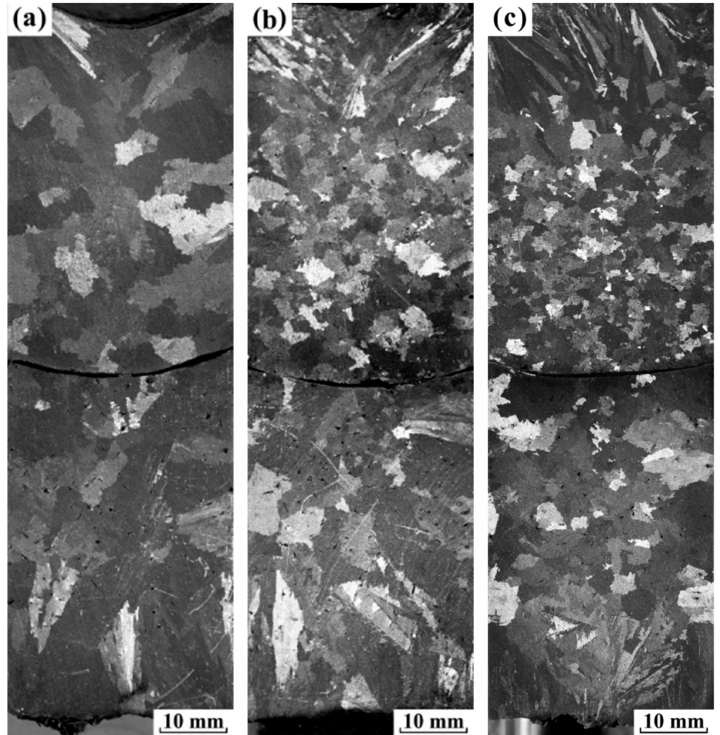
Figure 6. The as-cast macrostructure on the longitudinal section of Al-7Si alloy using sand mold embedded in a mesh plate placed along the cross section: ( a ) Without AECP; ( b ) under AECP with 400 A; ( c ) under AECP with 600